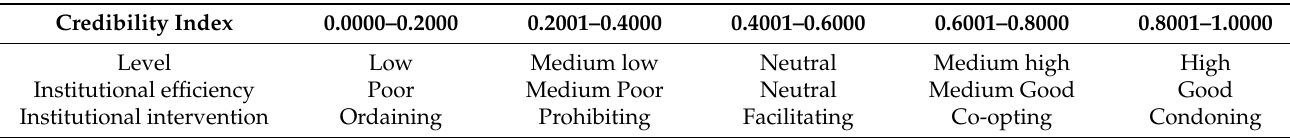
Table 5. Grading standards for institutional credibility and CSI.